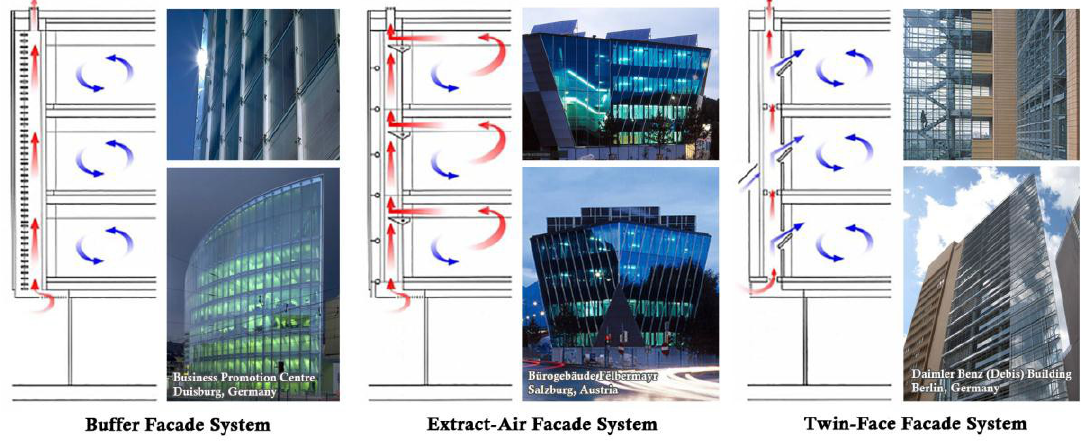
Figure 2. Examples of double façade types of buffer, twin face and extract-air, Source: